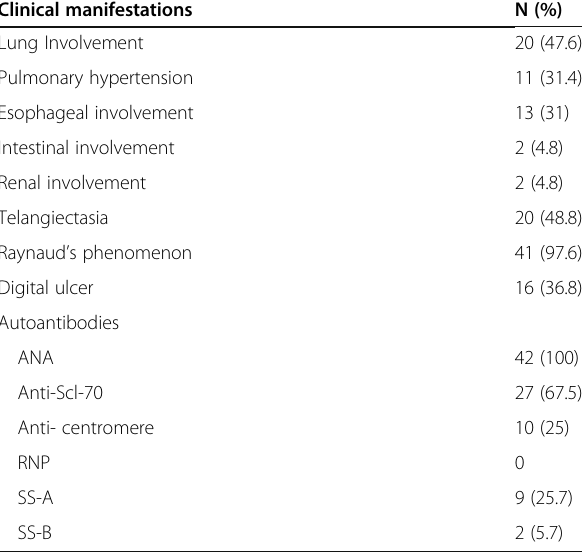
Table 1 Clinical manifestations of systemic sclerosis patients Clinical manifestations